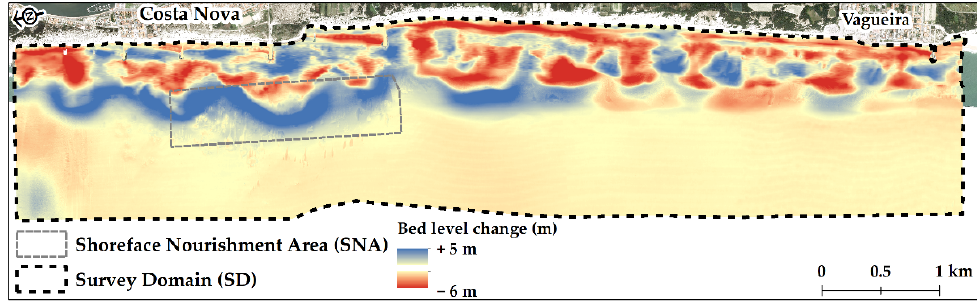
Figure 9. Morphological changes along the SD with respect to the pre-nourishment situation (June 2020) and after-nourishment (March 2021).